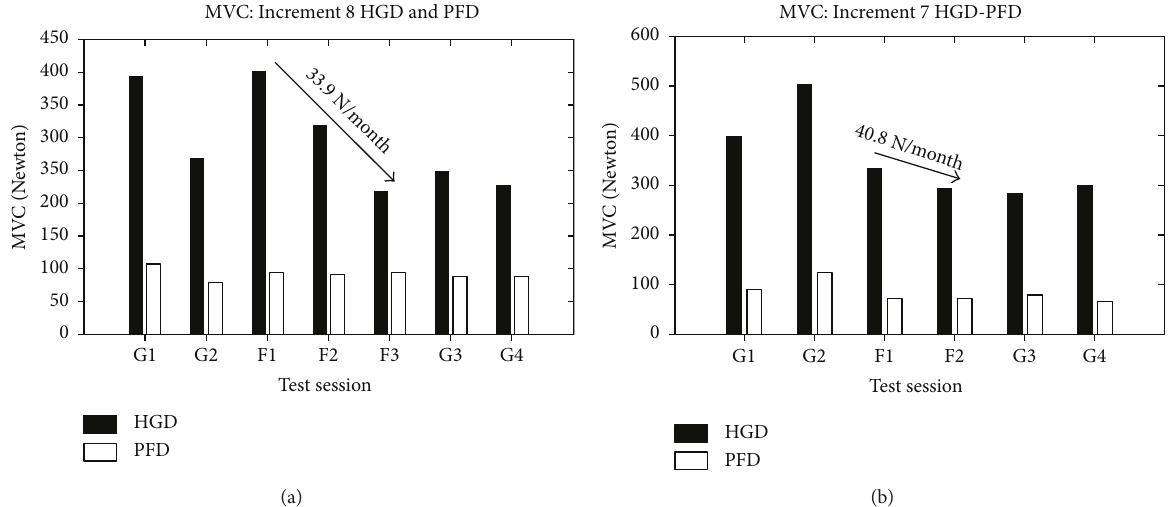
Figure 2: Maximum voluntary contraction (MVC). (a) Trend for increment 8 mission. (b) Trend for increment 7 mission. The timing of the di ff erent sessions is reported in Materials and